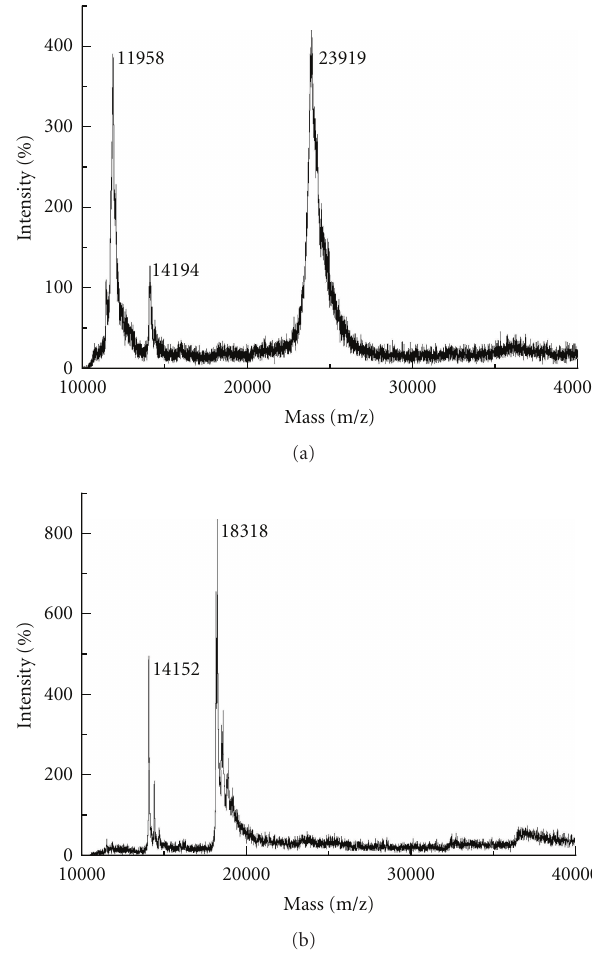
Figure 2: The MALDI-TOF mass spectra of bovine colostrum powder samples diluted with water rehydration (a) and bovine colostrum powder after cloud point extraction